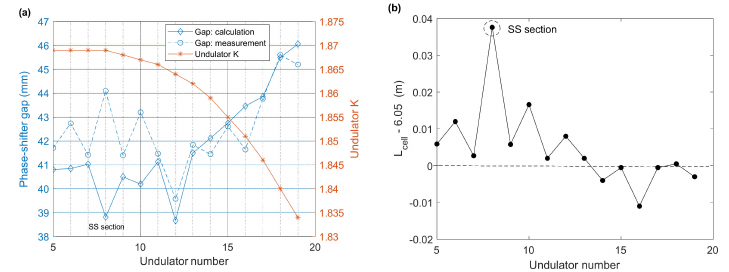
Figure 4. ( a ) The measured and calculated gap distance of the phase-shifters in the hard X-ray FEL line. ( b ) The calculated undulator cell distance, L c , to make the calculated phase-shifter gap the same as the